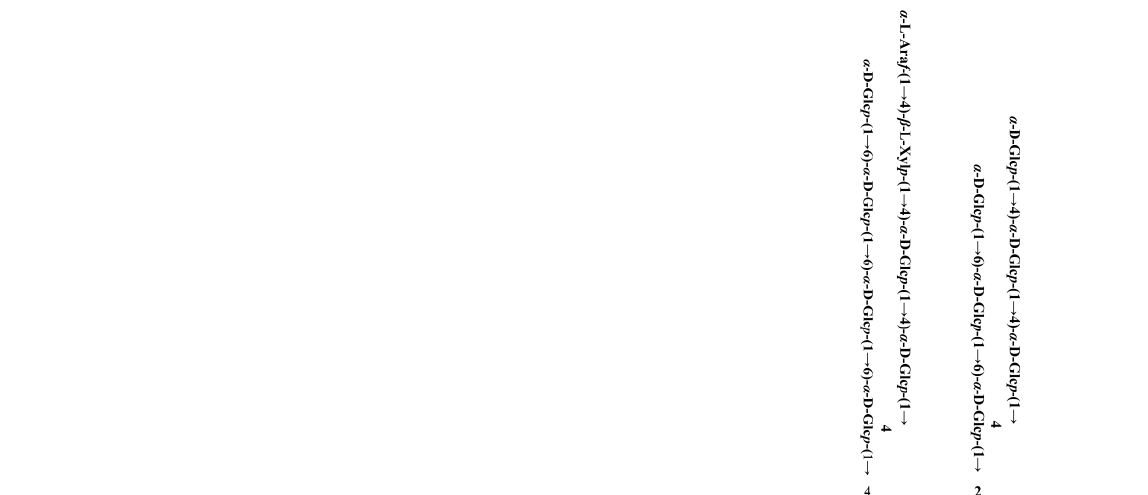
Figure 12. Putative structure of GLP-1.